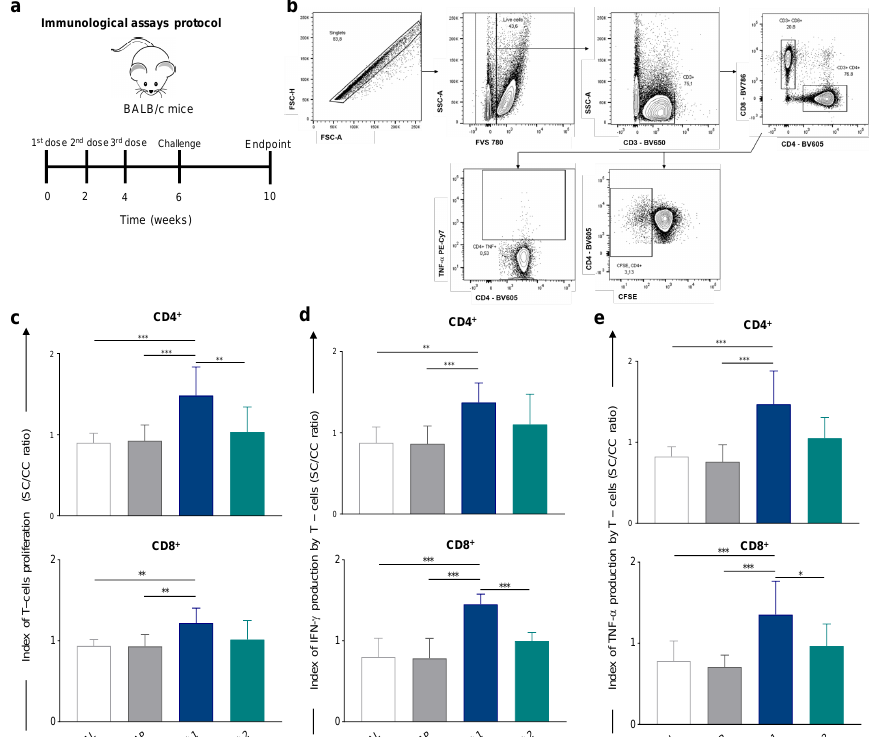
Figure 4. Spleen response after mice immunization with a cocktail of peptide-based vaccine and challenged with L. infantum . Cockt-1 promoted significant T-cell proliferation in spleens of immunized and challenged mice. ( a ) BALB / c mice were immunized three times and challenged with L. infantum promastigotes, four weeks after, splenocytes were obtained and T-cell proliferation and Th-1 cytokines wereassessedthroughflowcytometry. ( b )Representativeplotofgatingstrategytoevaluateproliferation of T-cell subpopulations and IFN- γ and TNF- α –producing T-cells. ( c ) Plots represent index of T-cells proliferation (SC / CC ratio) of T-CD4 + and T-CD8 + cells after in vitro stimulation with SLA (soluble Leishmania antigen). ( d ) Plots represent the IFN- γ production indexes (SC / CC ratio) of T-CD4 + and T-CD8 + cells. ( e ) Plots represent the TNF- α production indexes (SC / CC ratio) of T-CD4 + and T-CD8 + cells after in vitro stimulation with SLA. Indexes were calculated based on SLA-stimulated (SC) cultures divided by the control culture (CC). Data are expressed as means ± SD of two independent experiments ( n = 8). The p -values represent the di ff erence between the groups: * p- value < 0.05, ** p- value < 0.005, *** p- value <